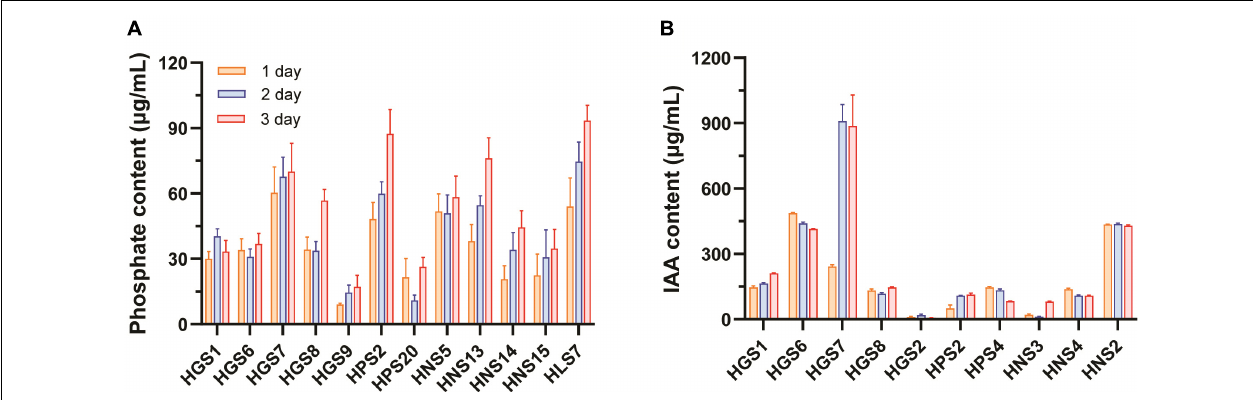
FIGURE 1 | Phosphate-solubilizing and IAA-producing capacity of rhizospheric bacteria of mulberry trees. (A) Phosphate-solubilizing activity. (B) IAA-producing activity. Data represent mean ± standard deviation ( n = 3).